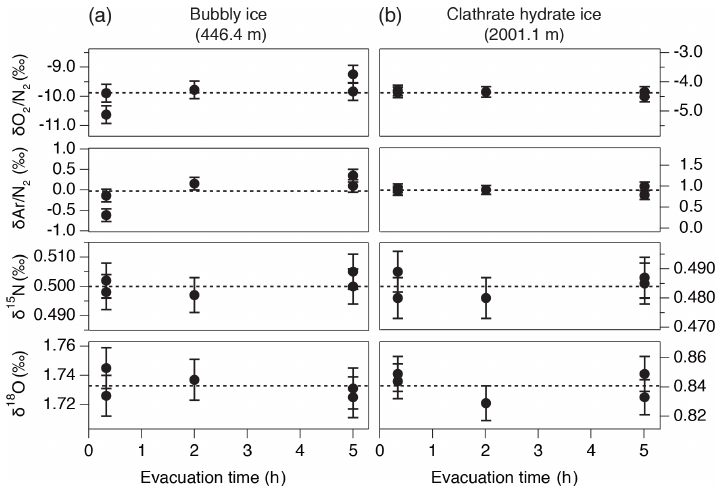
Figure B2. Results of the evacuation experiment for δ O 2 / N 2 , δ Ar / N 2 , δ 15 N, and δ 18 O in (a) bubbly ice (446.4m) and (b) clathrate hydrate ice (2001.1m). Dashed lines are the average of all five